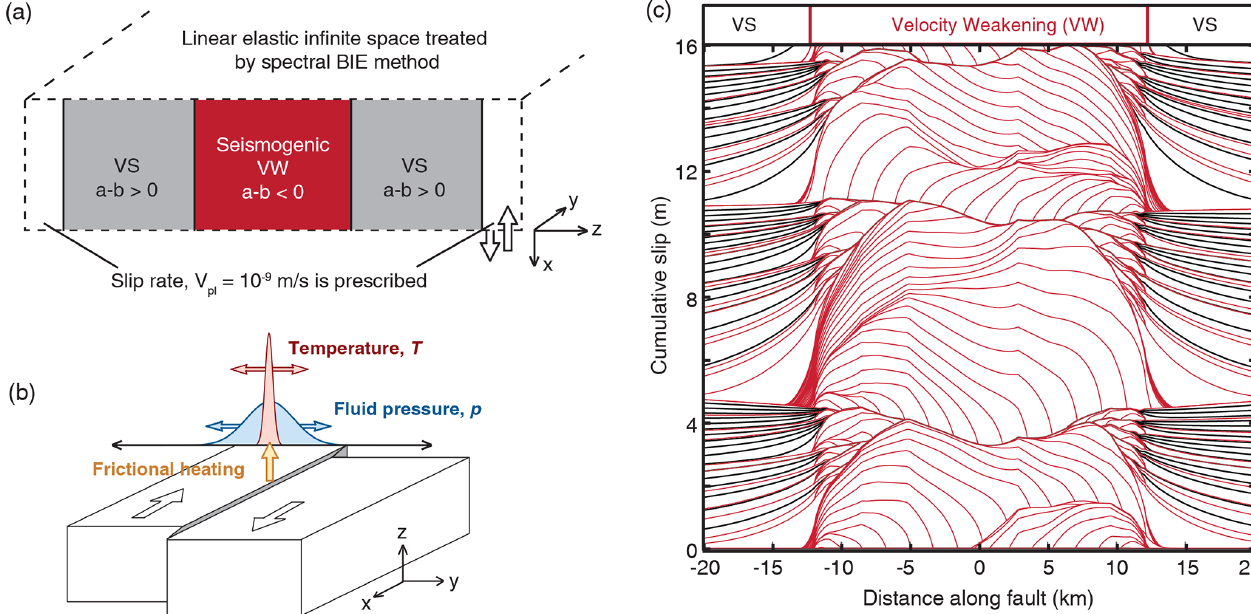
Figure 2. (a) The fault model incorporates a velocity-weakening (VW) seismogenic region surrounded by two velocity-strengthening (VS) sections. A fixed plate rate is prescribed outside of these regions. (b) We incorporate enhanced dynamic weakening due to the thermal pressurization of pore fluids by calculating the evolution of temperature and pore fluid pressure due to shear heating and off-fault diffusion throughout our simulations. (c) The beginning of the accumulated slip history for simulated sequences of crack-like earthquake ruptures and aseismic slip. Seismic events are illustrated by red lines with slip contours plotted every 0.5s and interseismic slip plotted in black every 10 years. The total simulated slip history spans 2675 years corresponding to cumulative slip of 84m and contains 200 seismic